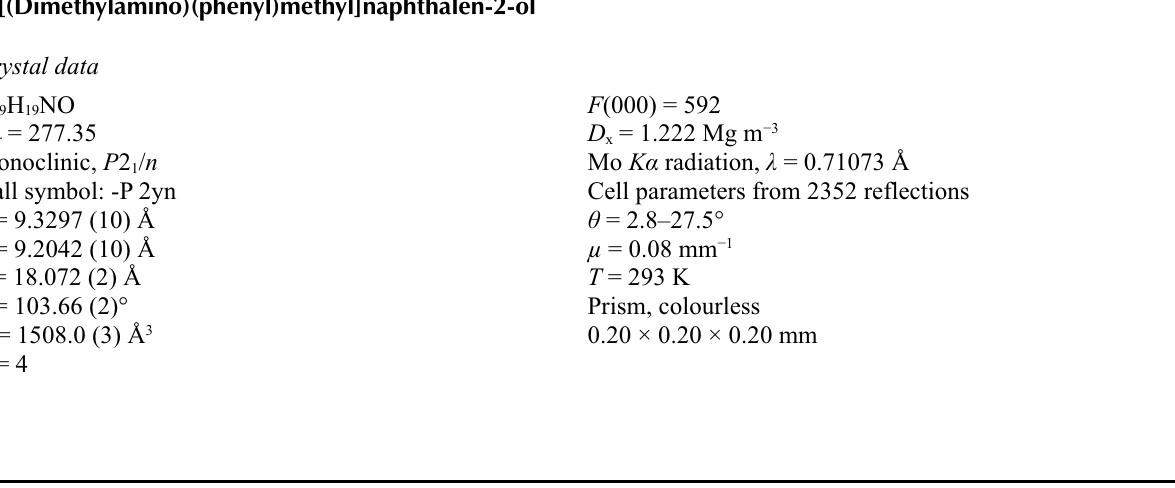
The structure of (I), showing the atom-numbering scheme. Displacement ellipsoids are drawn at the 50% probability level. The intramolecular hydrogen bond is indicated by a dashed